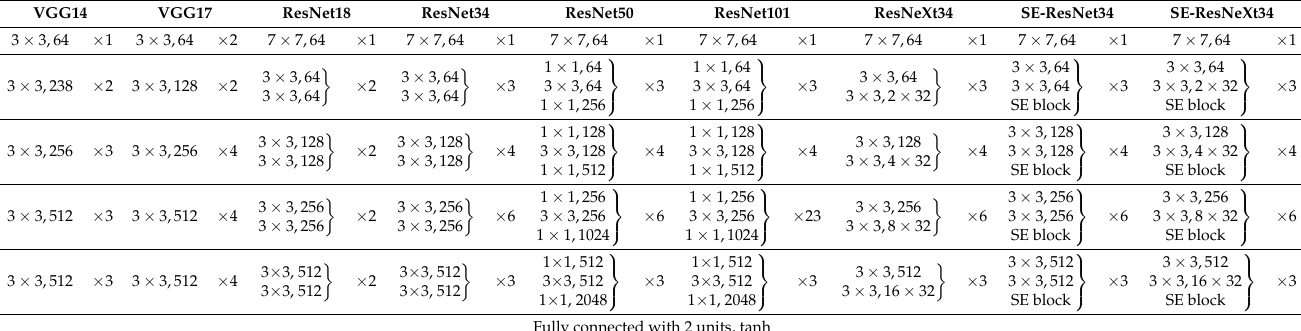
Table 2. The configurations of trainable layers for the proposed FER